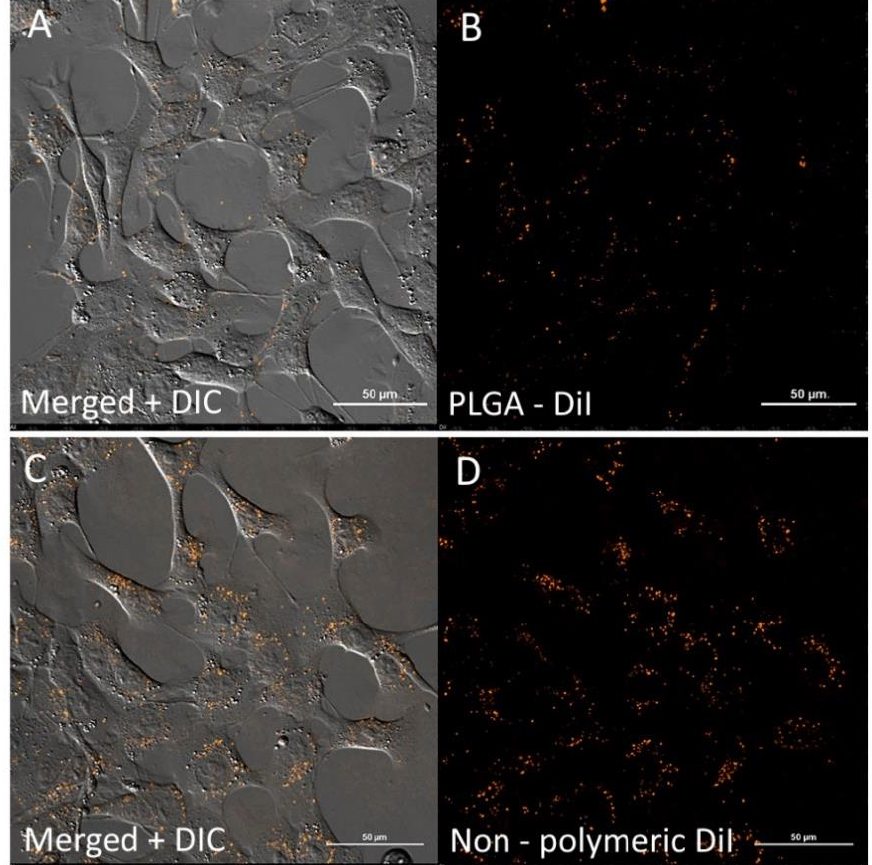
Figure 6. Laser scanning confocal microscopy of 4T1 cells after 40 min of incubation with DiI nanosuspension: PLGA-DiI NPs ( A , B ) and non-polymeric DiI formulation, stabilized with 1% PVA) ( C , D ). ( A , C )—merged image and differential interference contrast (DIC); ( B )—PLGA-DiI fluorescence; D—non-polymeric DiI fluorescence. Scale bar 50 μm.